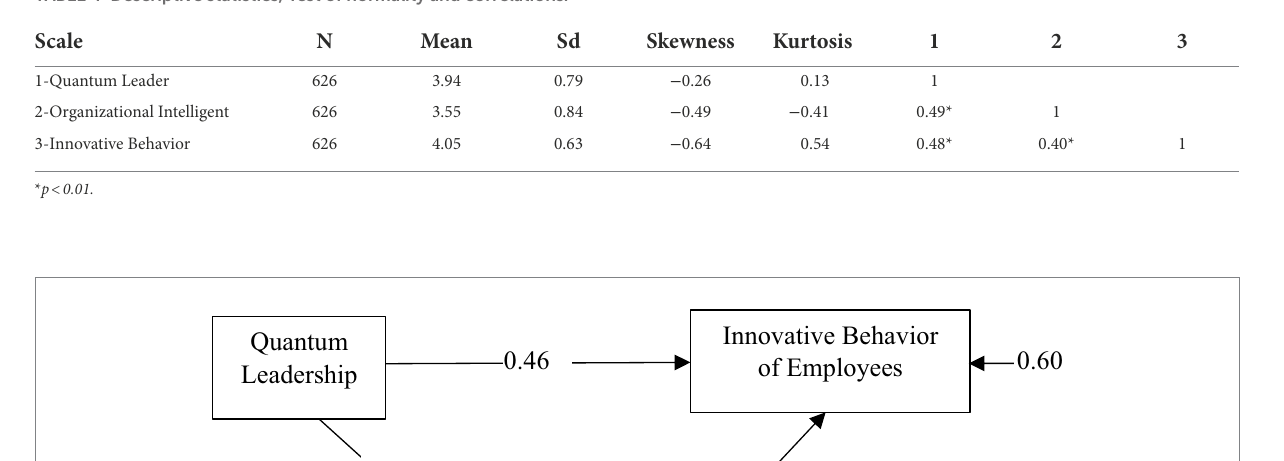
TABLE 4 Descriptive statistics, Test of normality and correlations.